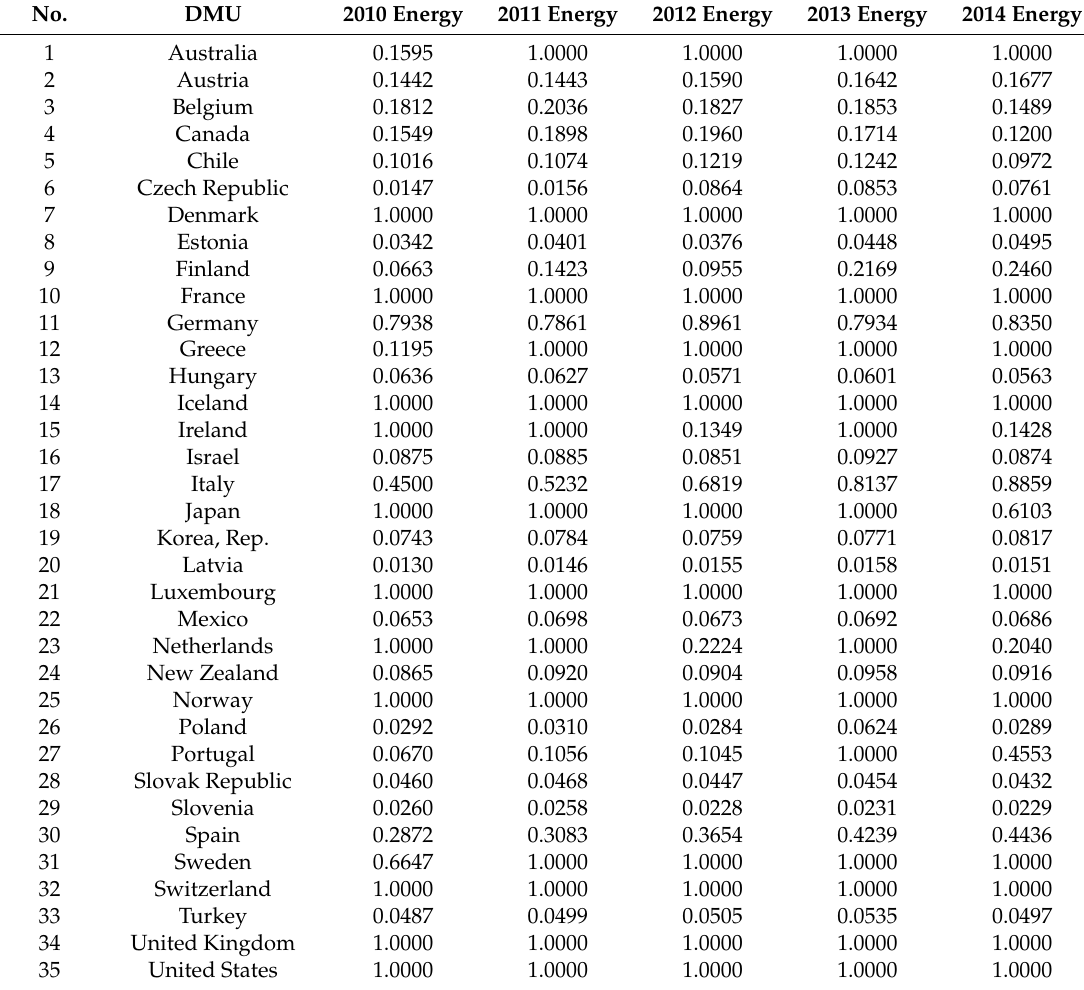
Table 5. Traditional energy consumption efficiency score from